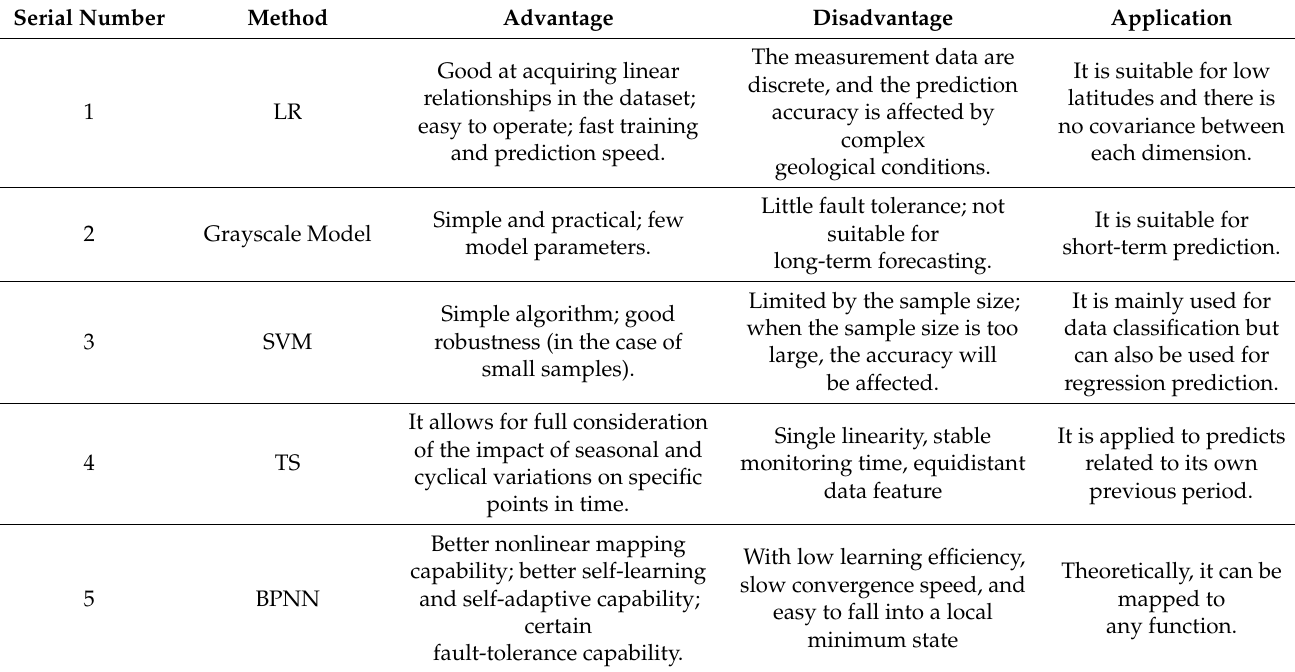
Table 1. Advantages, disadvantages, and applications of different methods